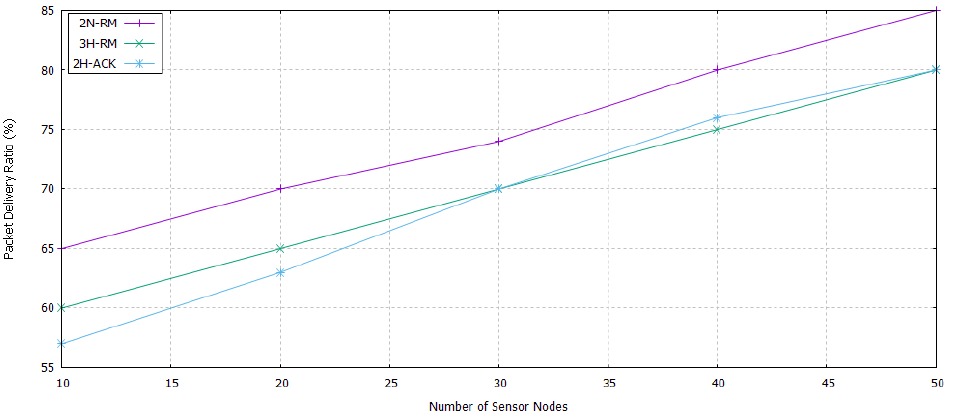
Figure 12. Packet Delivery Ratio of 2N-RM, 3H-RM, and